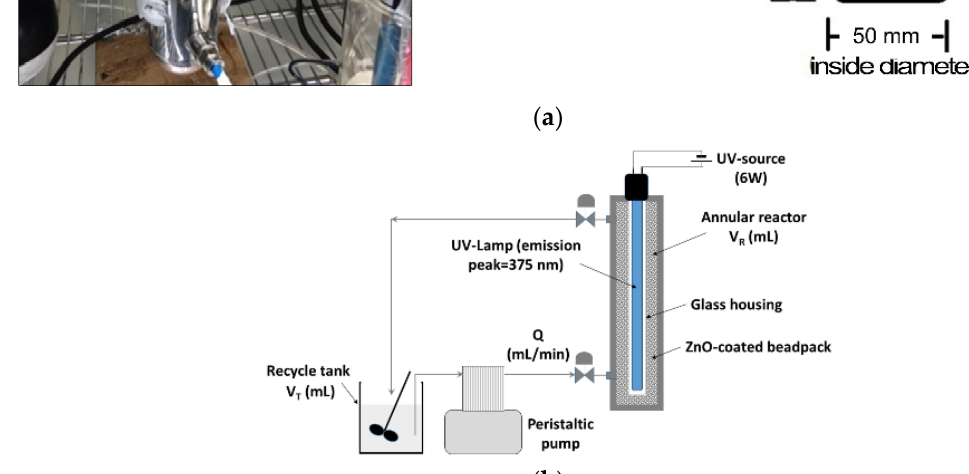
Figure 4. ( a ) Stainless-steel reactor with dimensions. ( b ) Schematic diagram of the experimental setup.